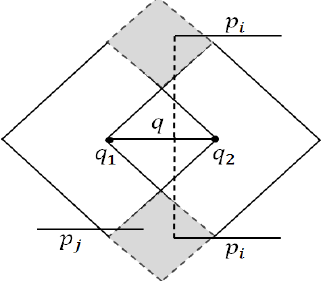
Figure 11. Symmetry of